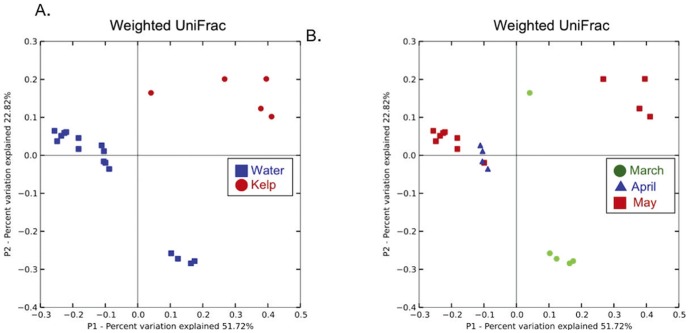
Weighed UniFrac principal coordinates analysis (PCoA) computed at exactly 510 sequences/sample illustrate the influence of sample type (Fig. 4A) and sample collection date (Fig. 4B).The coloring reflects the different dates on which the samples were taken (green  =  March, blue  =  April, red  =  May). “Kelp” refers to the kelp surface samples; “Water” refers to the seawater samples adjacent to the kelp sampled as well as those sampled outside the perimeter of the kelp forest. Percentages of variance explained by each principal coordinate (P1 and P2) are shown on the x- and y-axes.